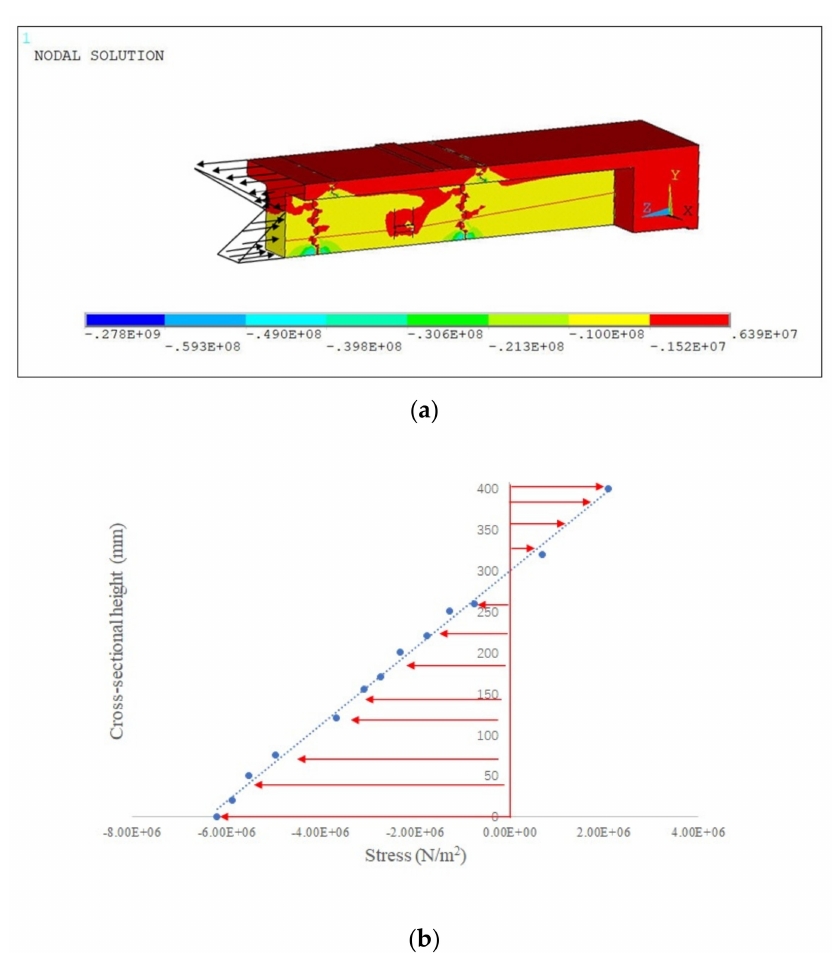
Figure 11. ( a ) The stress distribution contour in the longitudinal direction of the cross-section with strain gauges in S2. ( b ) Stress distribution over the cross-section with strain gauges in S2.